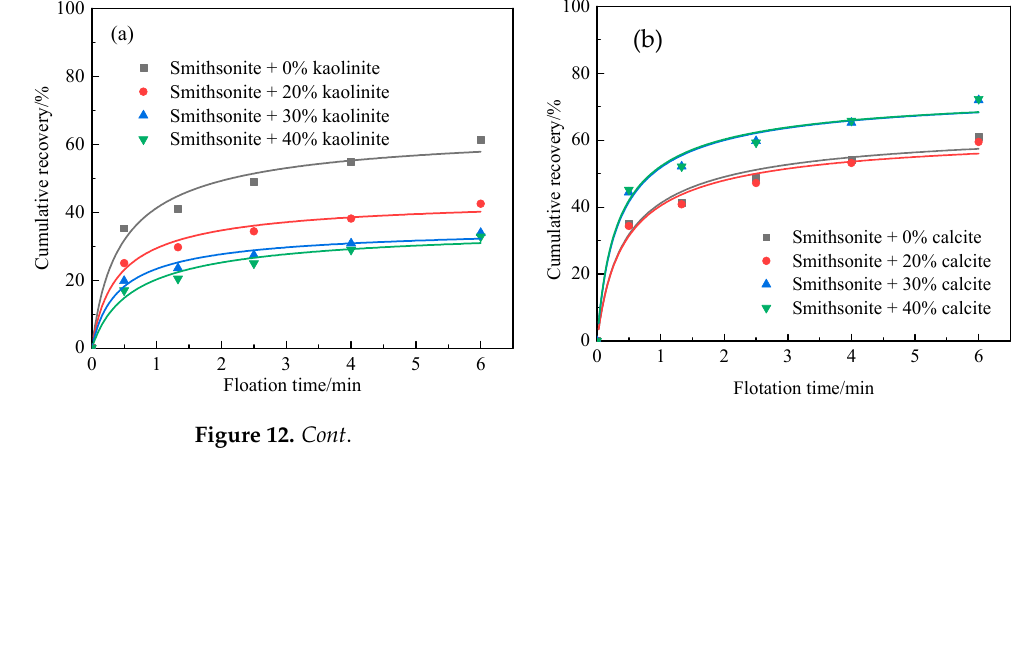
Figure 12. Effects of different gangue contents on flotation behavior of smithsonite using octadecylamine concentration: 150 mg/L at pH 9.5–10 and 28.57% solid concentration. In order to better understand the mechanism of different gangue minerals affecting the flotation of smithsonite, SEM-EDS was used to analyze the flotation concentrates of the mixed minerals. The results are shown in Figures 13–15. It can be seen that kaolinite, as a clay mineral that is relatively loose in shape, showed an adherent state on the surface of smithsonite, producing an obvious aggregation. Therefore, it can be concluded that kaolinite has a great impact on the pulp environment. Quartz and smithsonite, calcite, and smithsonite existed in a relatively dispersed form and did not produce obvious aggregation. Therefore, it can be concluded that quartz and calcite have little impact on the pulp environment.